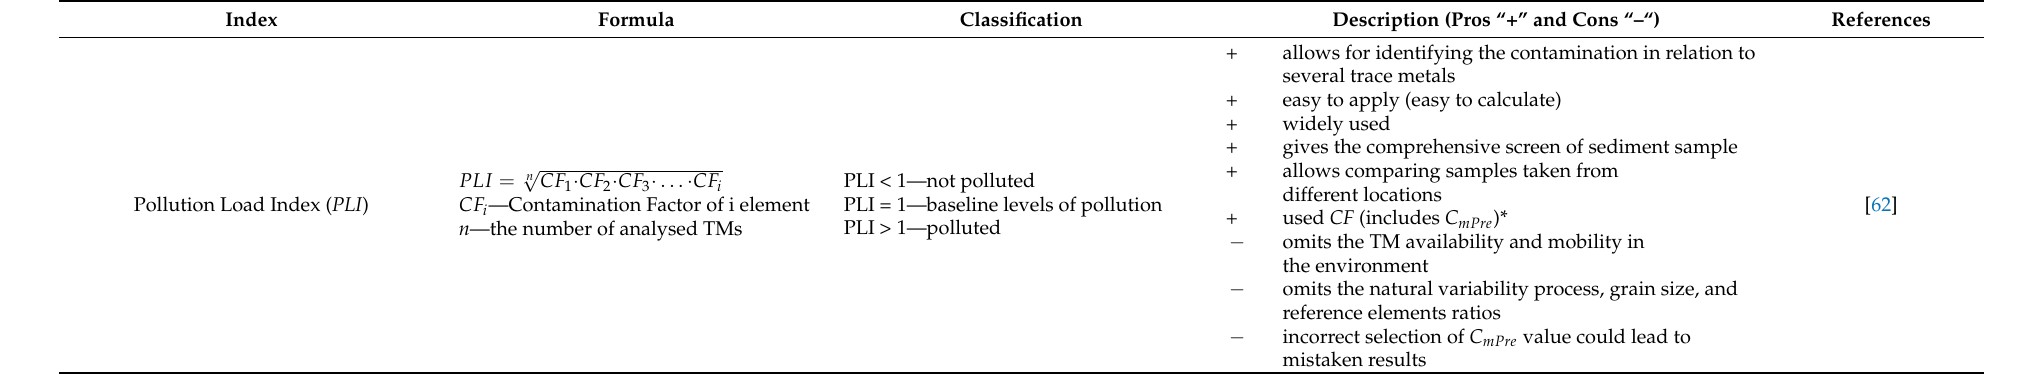
Table A3. A list of Complex Pollution Indices (CPIs) given in the literature with classification and basic description of strengths and